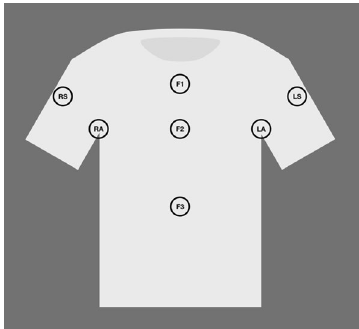
Figure 1. T-shirt inoculation regions for MS2 and E. coli . RS and RA refer to the Right Sleeve and Right Armpit; LS and LA refer to Left Sleeve and Left Armpit; F1, F2, and F3 refer to Front 1, 2, and